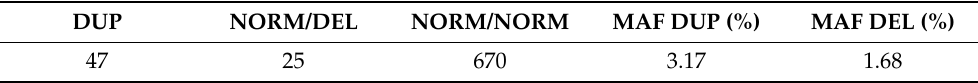
Table 4. Diplotype distribution and allele frequencies for CYP2D6*5 ( CYP2D6 gene deletion—DEL)